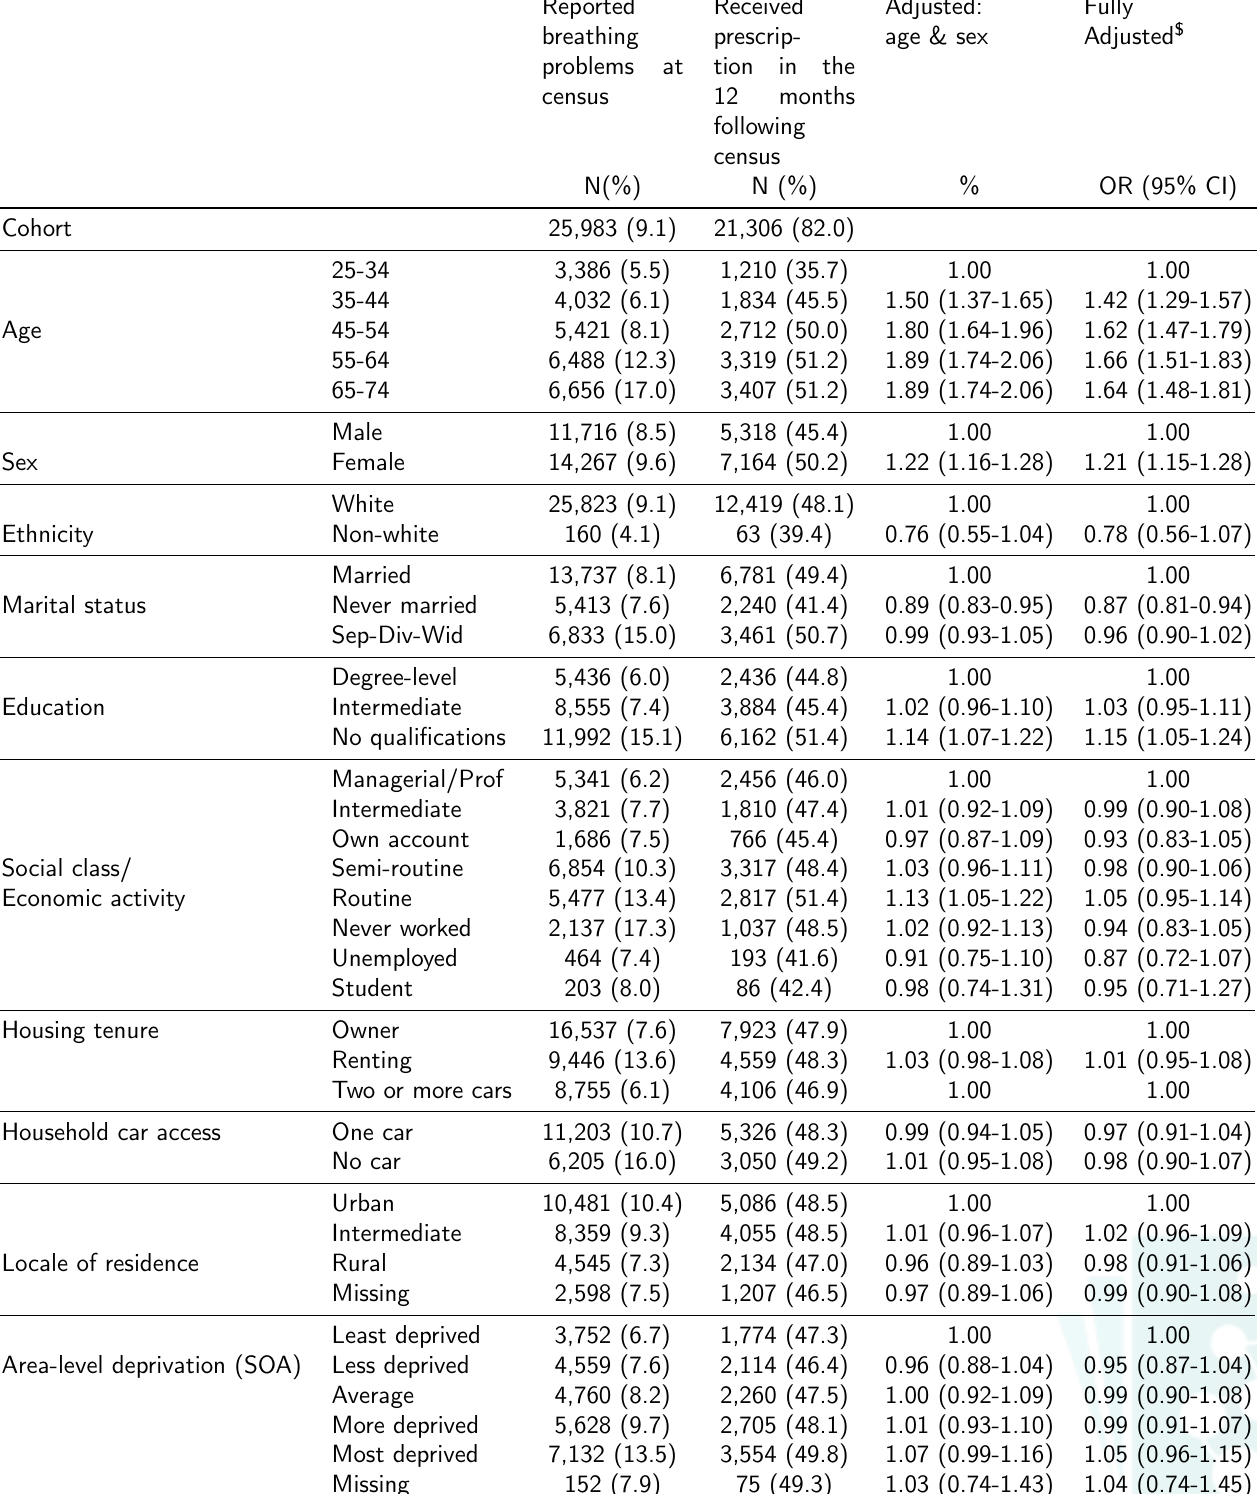
Table 3: Proportions and characteristics of the people aged 25-74 who reported breathing difficulties at Census and the factors associated with the likelihood of receiving respiratory medical treatment in the following 12 months. Data represent numbers (percentages) and Odds Ratios (95% Confidence Interval) from logistic regression